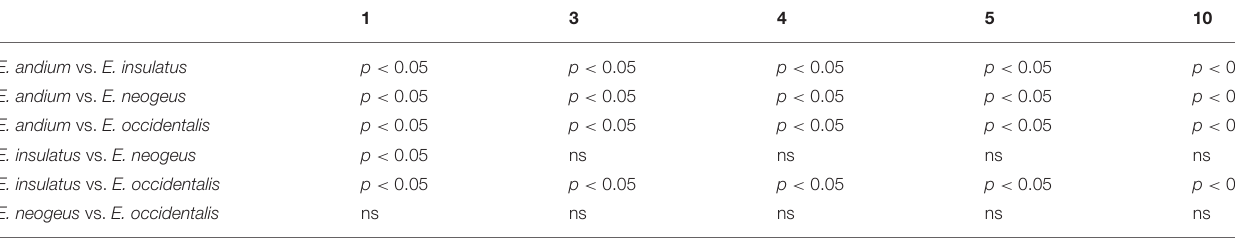
TABLE 2 | Kruskal-Wallis test results for comparative analysis of MCIII.